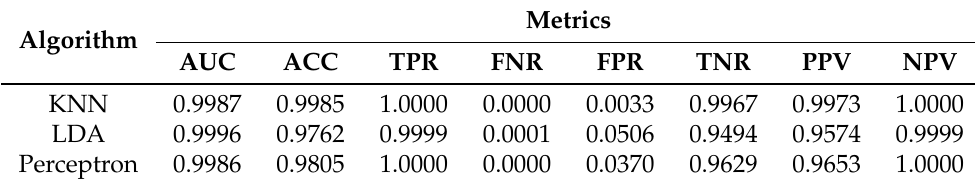
Table 3. The mean value for each metric for each algorithm—Banknote Authentication dataset.